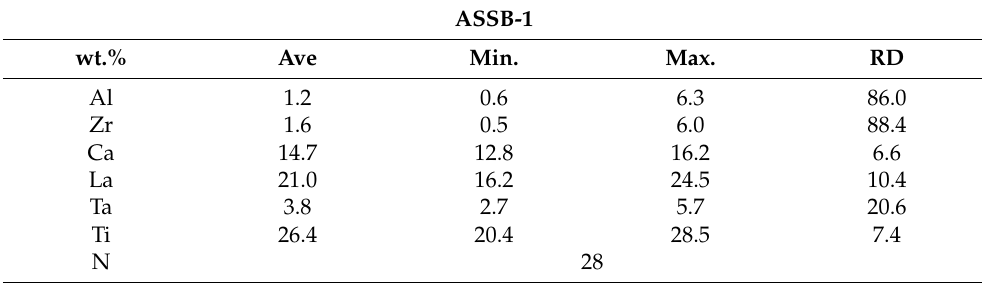
Table A6. Composition of Pv (wt.%) based on single-point analysis (only in ASSB-1). Ave.: arithmetic average; Min./Max.: lowest/highest measured values; RD: relative standard deviation (%);N: number of measurements.